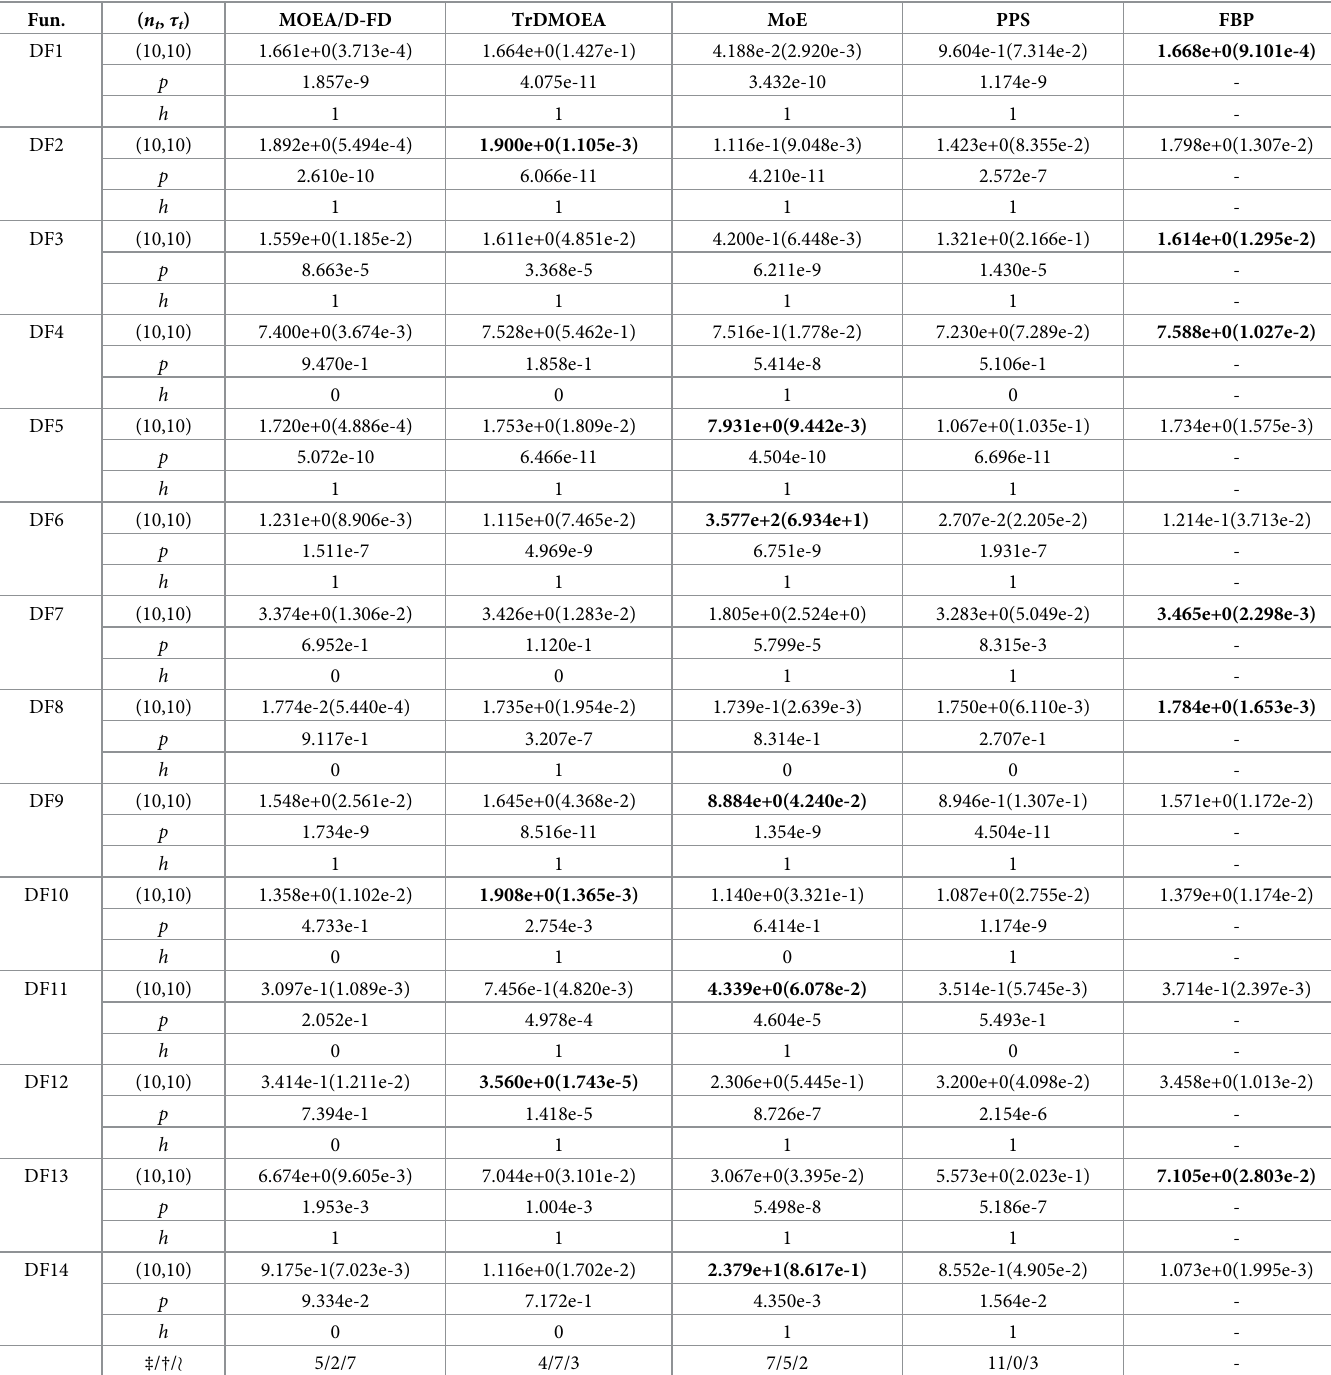
Table 5. Mean and standard deviation values of MHV obtained by five algorithms for ( n t , τ t ) = (10,10).